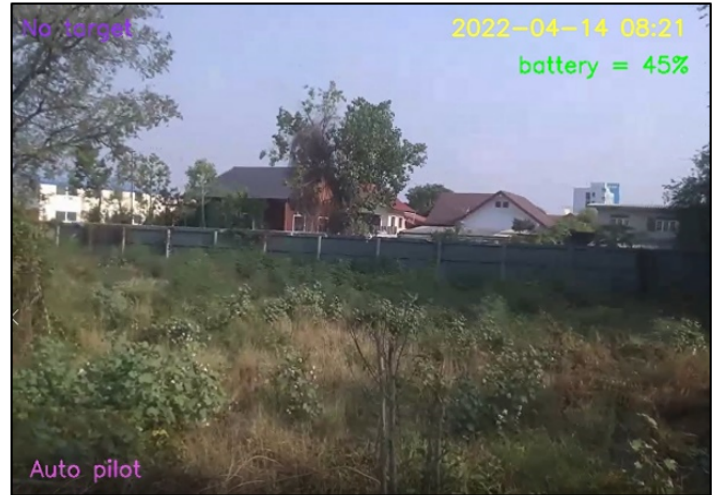
Figure 29. True negative detection.